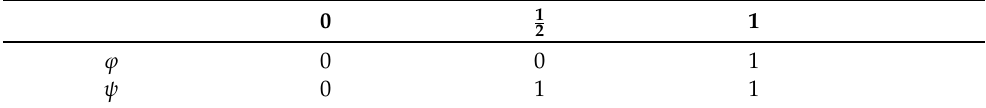
Table 4. Graded operator ϕ and its dual graded operator ψ on L 3 . 0 1 1 2 ϕ 0 0 1 ψ 0 1 1